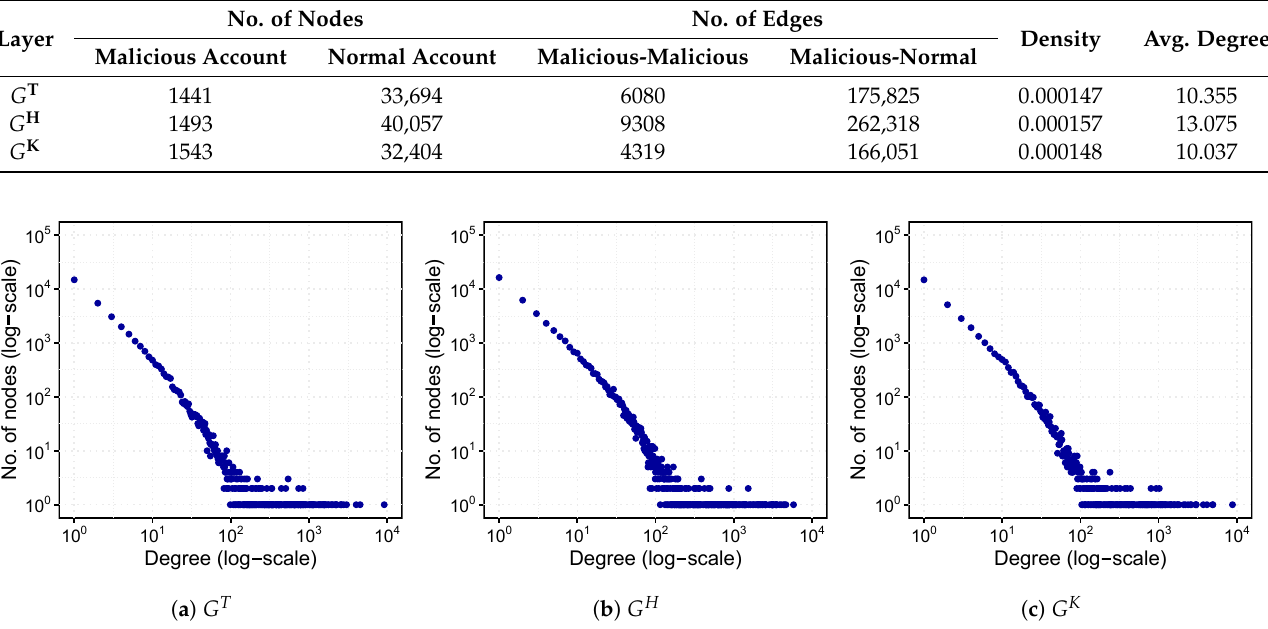
Table 2. Characteristics of the ACMN.